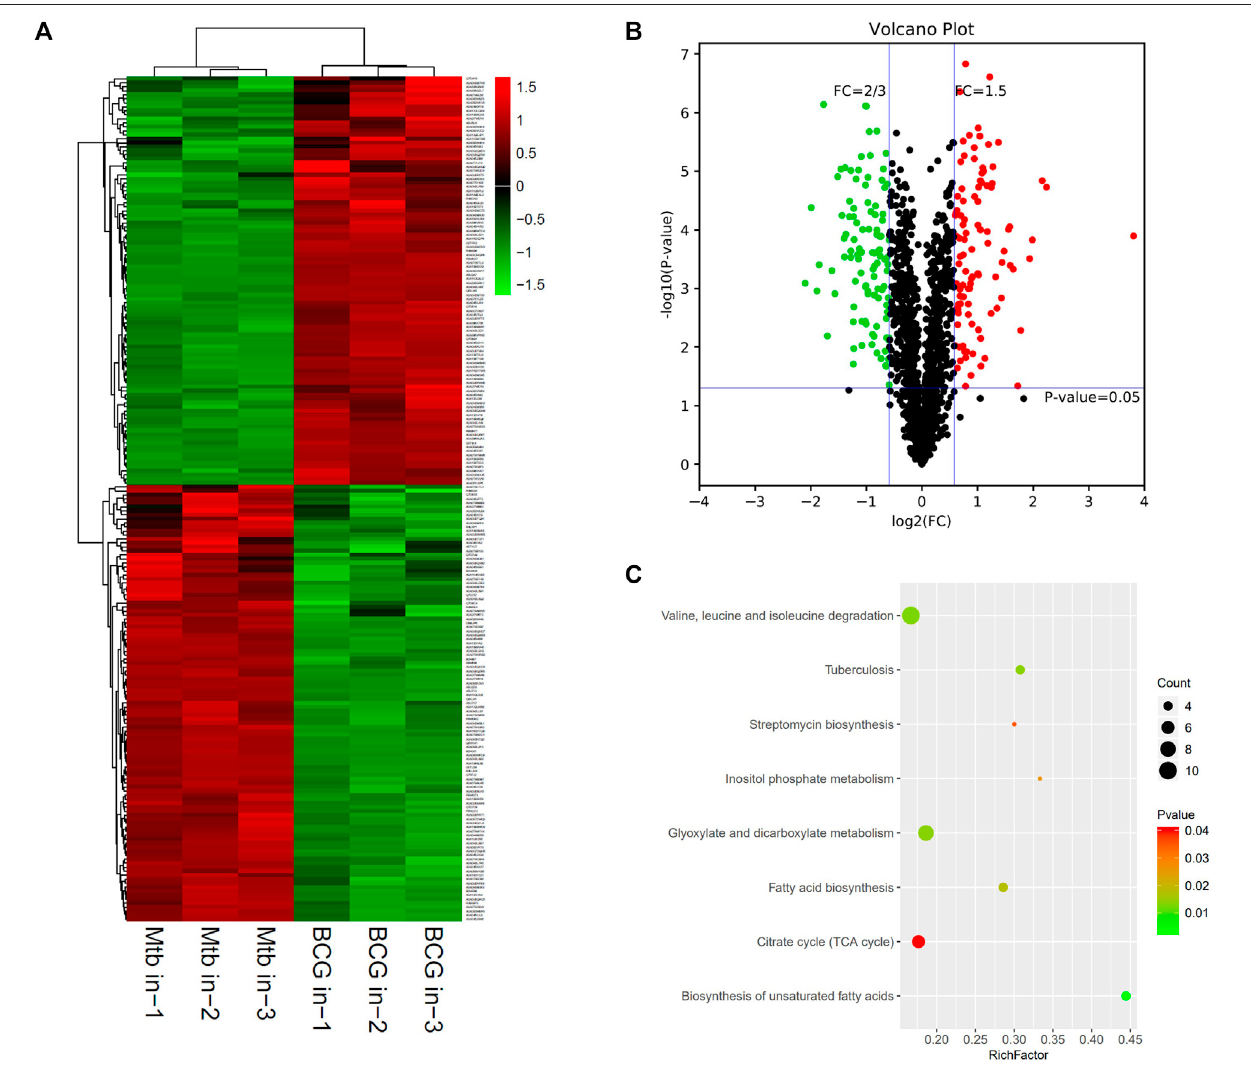
FIGURE 4 | Different protein pro fi le between intracellular BCG and intracellular M.tb . (A) Heatmap of proteins differentially expressed between the group of intracellular BCG and intracellular M.tb . Green-to-red scale indicates low-to-high proteins expression levels ( p < 0.05). (B) Volcano plots of proteins differentially expressed between the group of intracellular BCG and intracellular M.tb . The red dots on the right indicate the signi fi cantly upregulated proteins, whereas the downregulatedareshown withgreen dotsontheleft. Differentiallyexpressed proteins werede fi ned based onathreshold foldchange > 1.5, at p < 0.05. (C) Top10 KEGG pathways (only eight in this group) enriched for the signi fi cantly differentially expressed proteins. Entries with larger bubbles contain more differential genes. The color of the bubbles indicates the p value. The smaller the enrichment p value means the greater the degree of signi fi cance ( p < 0.05).